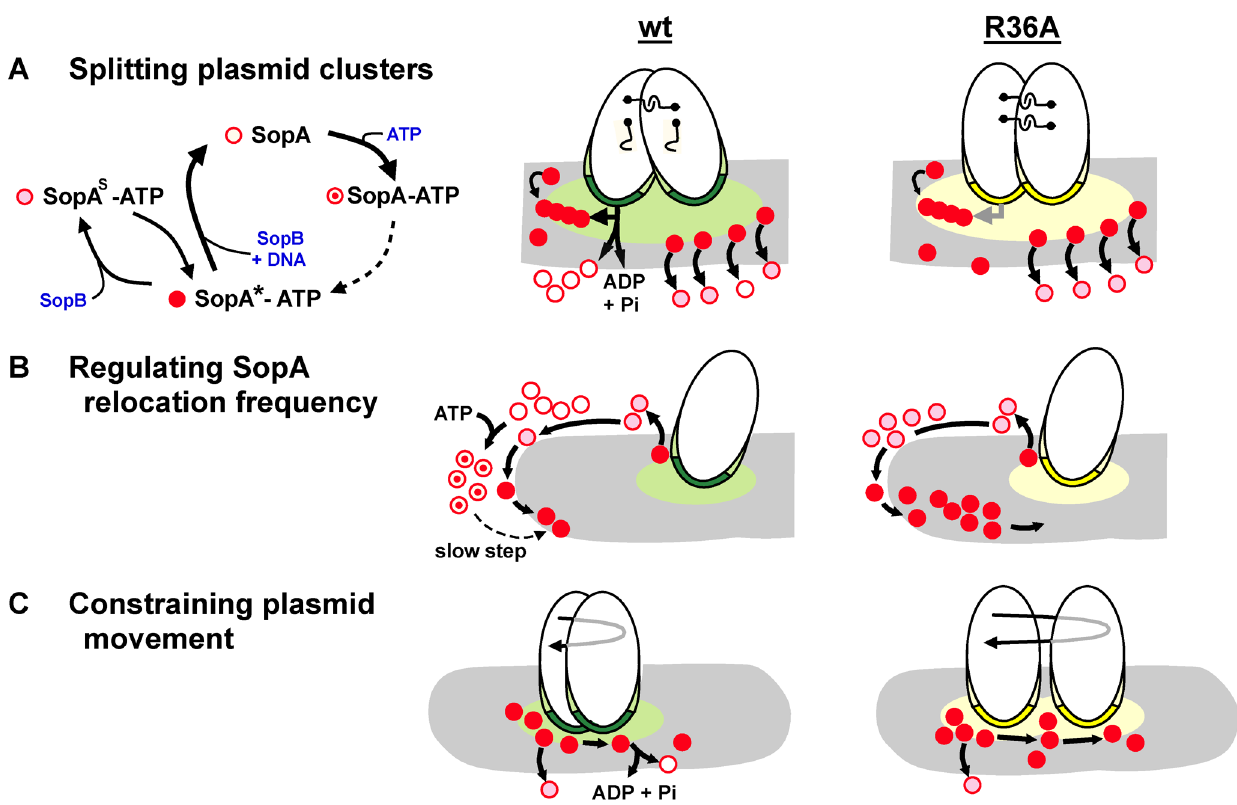
Figure 7. Steps in partition at which SopB stimulates SopA to hydrolyse ATP. Mini-F plasmids are shown oval with SopB bound to sopC in the partition complex as dark green (wt) or yellow (R36A) and SopB spread in cis or onto the nucleoid (grey) in the corresponding lighter shade. No distinction is made here between direct binding of SopB to the nucleoid and binding via SopA tethers; the latter option is favoured by recent observations of partition complex movement as a function of SopA-ATP disassociation from a DNA carpet [31]. Distinct functional forms of SopA are shown in the key as: SopA*-ATP, able to bind to non-specific DNA (corresponding to ParA* 2 -ATP 2 ; [23]); SopA S -ATP, modified by SopB to be unable to bind non-specific DNA [31]; SopA, without ATP following hydrolysis; SopA-ATP, associated with ATP but not having undergone transition to the DNA- binding form [23]. A. Model of SopB-stimulated splitting of clusters. SopB spreads from clustered partition complexes, creating a mat which attracts SopA-ATP and shelters it from the nucleoid to allow SopA polymerization [21]. For clarity only one polymer (chain of red dots) and its interactions is shown, at the left of the SopB mat. Polymer contact (horizontal arrow) with SopB- sopC initiates a hydrolysis-driven transfer of each partition complex to successive polymer subunits which generates the force to break inter-plasmid links (shown as hooks). Hydrolysis stimulation by SopB-R36A is too low to drive this process efficiently. Following splitting, the SopB mat shrinks, attenuating polymerization and this mode of plasmid separation. The separation mode that positions plasmid molecules (e.g. diffusion-ratchet; [20,23]; shown at right of SopB mats) is mostly independent of ATP hydrolysis [31] and is activated by both wt and R36A SopB complexes. B. Model of SopA priming for relocation. Relatively slow conformational transitions [23] must raise the level of SopA-ATP competent to start relocation from the pole. Most of the SopA-ATP dislodged by the R36A partition complex does not hydrolyse its ATP, does not need the transition, and so reverses direction without delay. C. Model of restricted F plasmid movement. The extended partition complex of a segregated plasmid encounters nucleoid-bound or relocating SopA molecules at random and moves as dictated by local SopA dynamics. Wt SopB complexes stimulate ATP hydrolysis, disrupting SopA-SopB contact [35] and curtailing movement, whereas R36A complexes do not, leading to a wider ambit (longer reverse arrow), accounting for the exaggerated position adjustments seen in Figure 6.